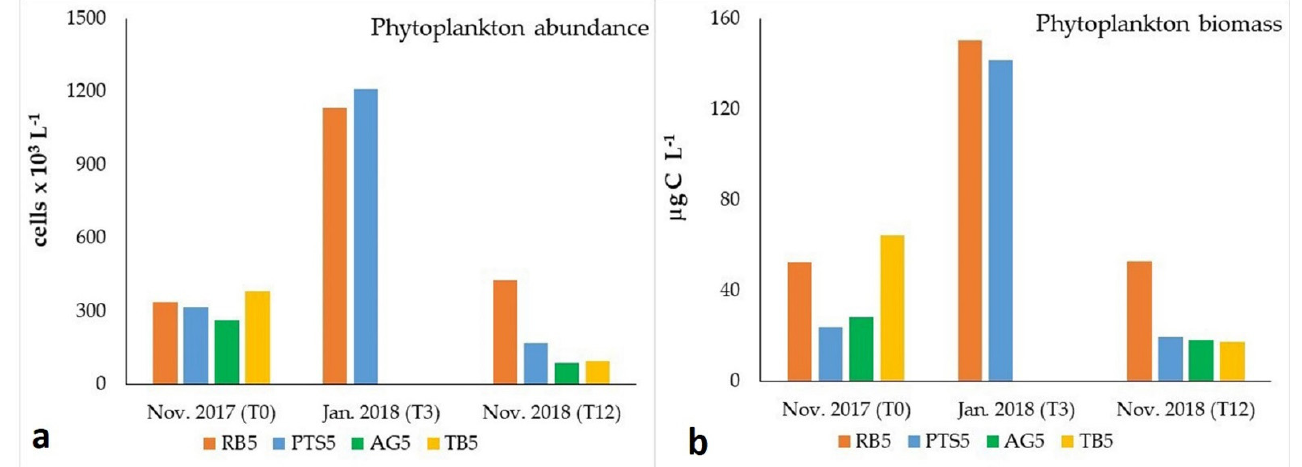
Figure 10. Phytoplankton abundance ( a ) and biomass ( b ) measured in seawater samples collected at 5 m in November 2017, January and November 2018 (Times 0, 3 and 12, respectively). ( a ) Road Bay area; ( b ) Tethys Bay area. RB, Road Bay (impact station); PTS, Punta Stocchino (control station); AG, Amorphous Glacier (impact station); TB, Tethys Bay (control station).